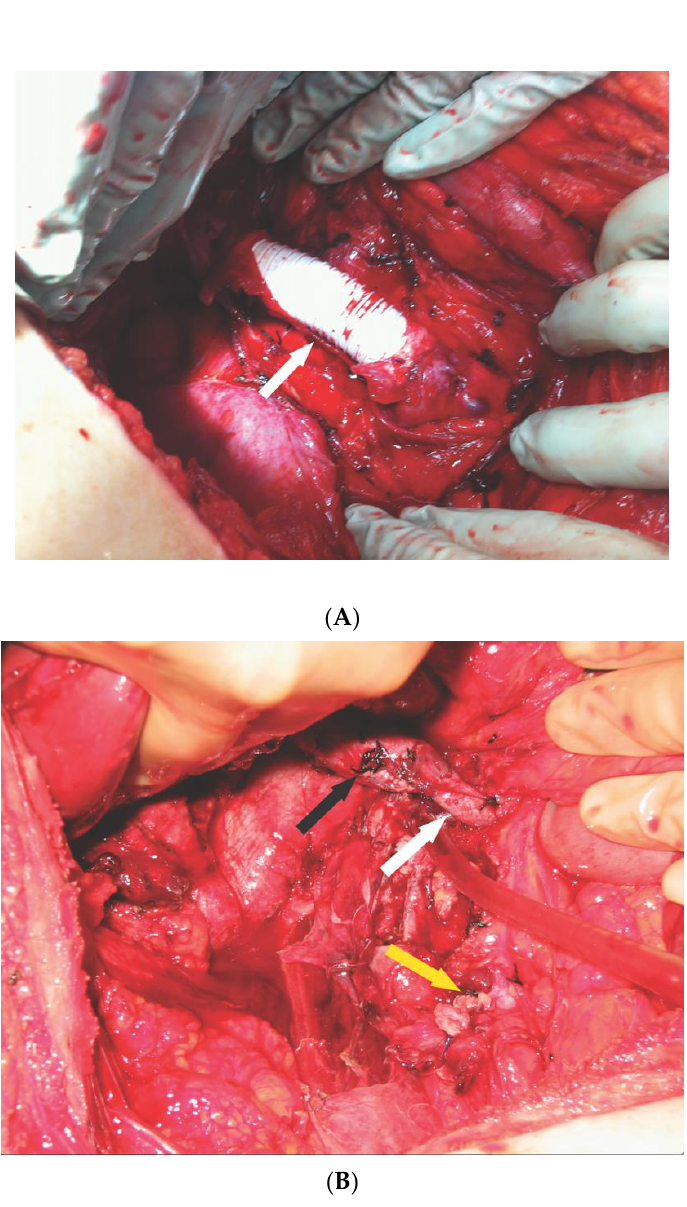
Figure 3. ( A ), Inferior vena cava (IVC) reconstructed with ringed polytrafluoroethylene graft (white arrow) with IVC filter placed inside the graft; ( B ) Anastomosis of the proximal IVC (black arrow) anastomosed to remnant of the left renal vein (white arrow), distal IVC was oversewn (yellow arrow).